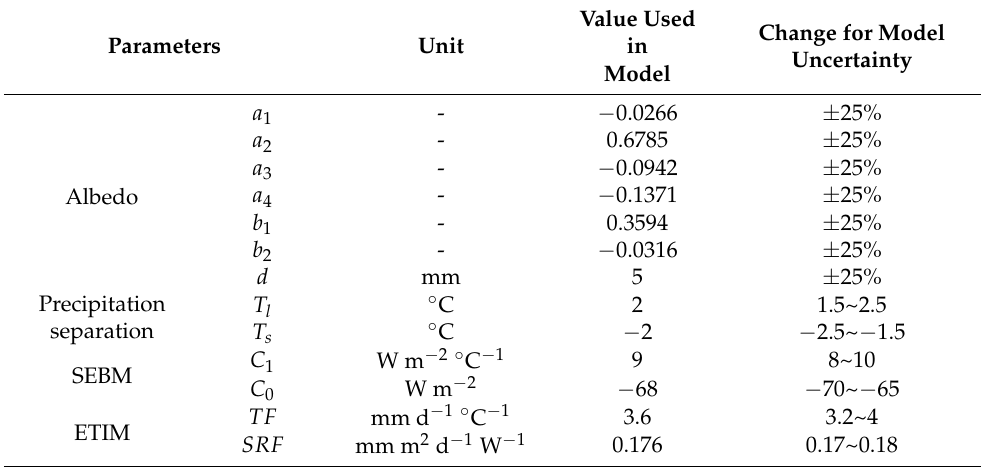
Table 1. Parameters of the SEBM and ETIM and the range of parameter change is used to estimate model uncertainty. Value Used Change for Model Parameters Unit in Uncertainty Model a 1 - − 0.0266 ± 25% a 2 - 0.6785 ± 25% a 3 - − 0.0942 ± 25% a 4 - − 0.1371 ± 25% Albedo b 1 - 0.3594 ± 25% b 2 - − 0.0316 ± 25% d mm 5 ± 25% Precipitation T l ◦ C 2 1.5~2.5 separation T s ◦